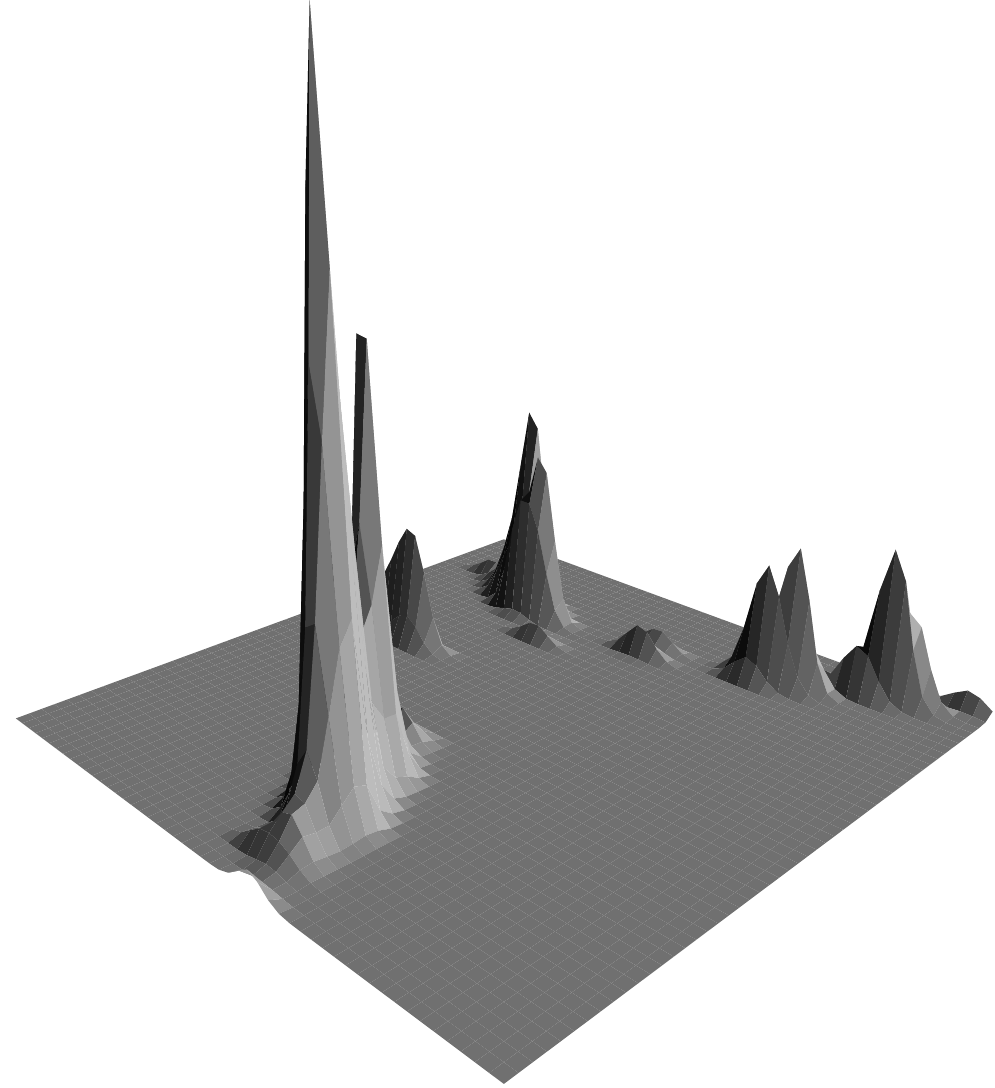
Figure 3. Density surface of the cophenetic space, based on the MB trees from the “tall” dataset. This surface is the result of multidimensional scaling of the cophenetic distances between tree tips; density of points estimated with 2D binned kernel. “Ridges” reflect areas with the highest density and correspond well with three major subgeneric divisions of Plantago . Note the three-fold structure of the “phylogenetic surface”: tallest corresponds with Plantago subg. Plantago , close and behind it, is Plantago subg. Coronopus whereas Plantago subgg. Psyllium and Albicans are the